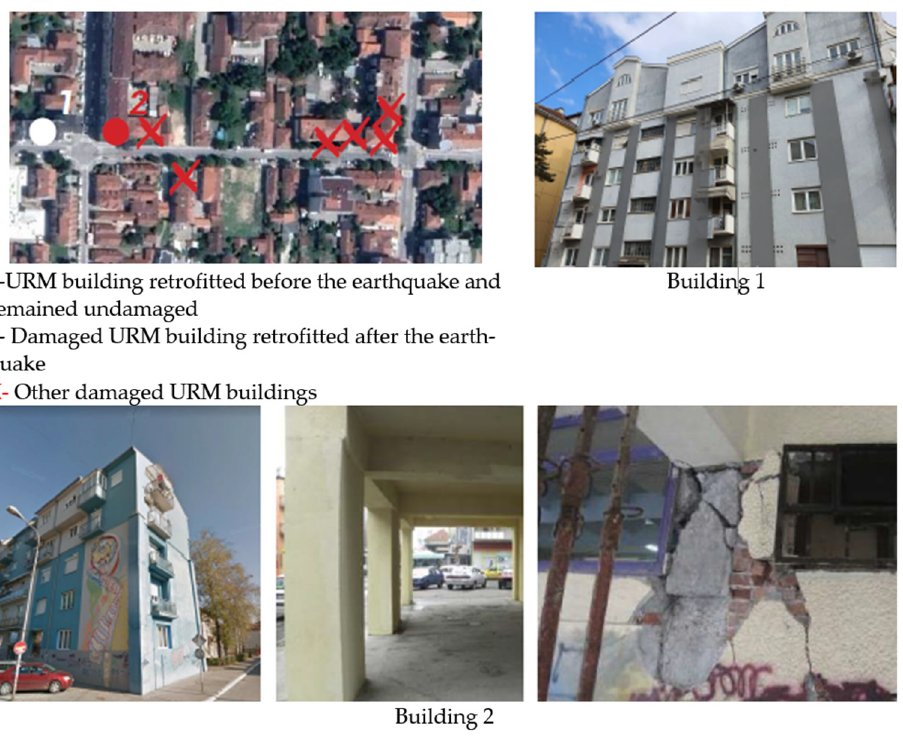
Figure 13. Jug Bogdanova Street in Kraljevo, Serbia after the 2010 earthquake: examples of damaged and undamaged masonry buildings.